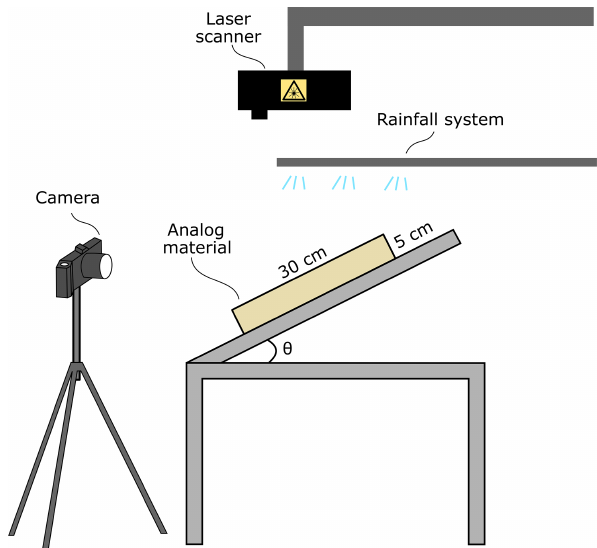
Figure 4. Schematic representation of the experimental setup used for models with only erosion: block of experimental ma- terial (35cm × 30cm × 5cm), rainfall system (commercial sprin- klers) and reclining table. A single camera and a high-definition laser scan provide records for the